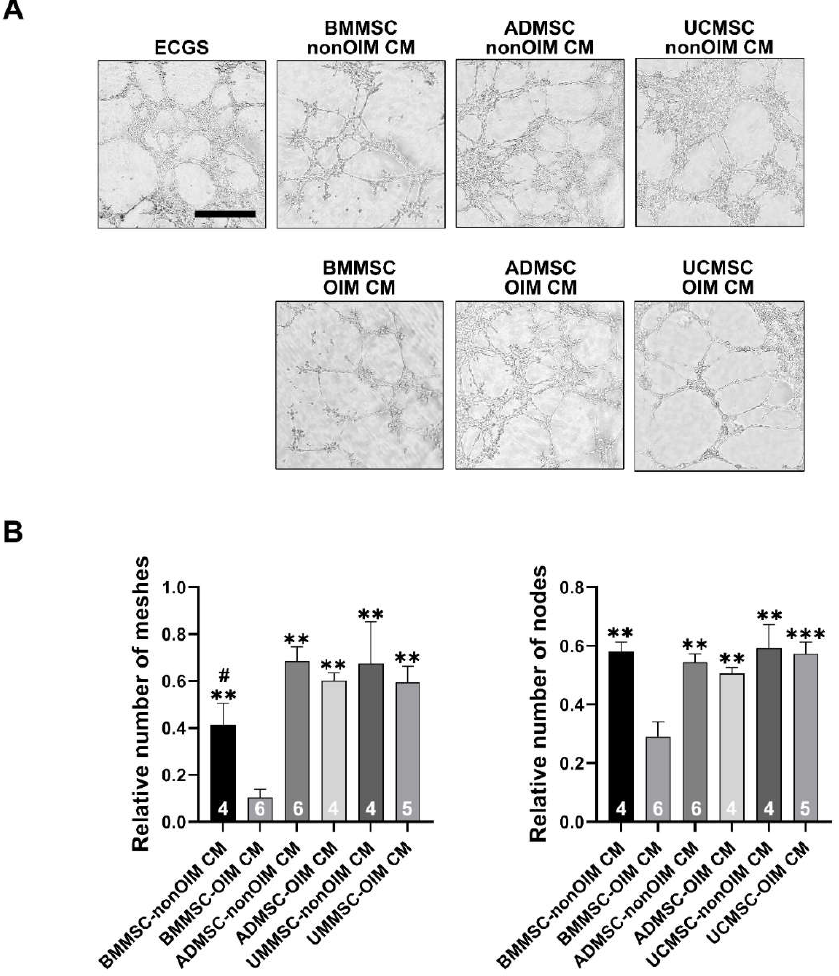
Figure 3. Tube formation assay for analyzing the angiogenic potential of MSC secretomes. ( A ) Mi- crographs of tube formation of HUVECs treated with osteo-induced (OIM) or noninduced (nonOIM) MSC-CMs. ( B ) CM groups were normalized with the ECGS group and expressed as a relative number of meshes and nodes. Bars are presented as mean ± SEM. The number of replicates is inside the bars. A one-way ANOVA with Tukey’s post hoc test was used to determine statistical significance (** p < 0.01, *** p < 0.001 vs. BMMSC-OIM CM; # p < 0.05 vs. ADMSC-nonOIM CM). Scale bars are 500 µ